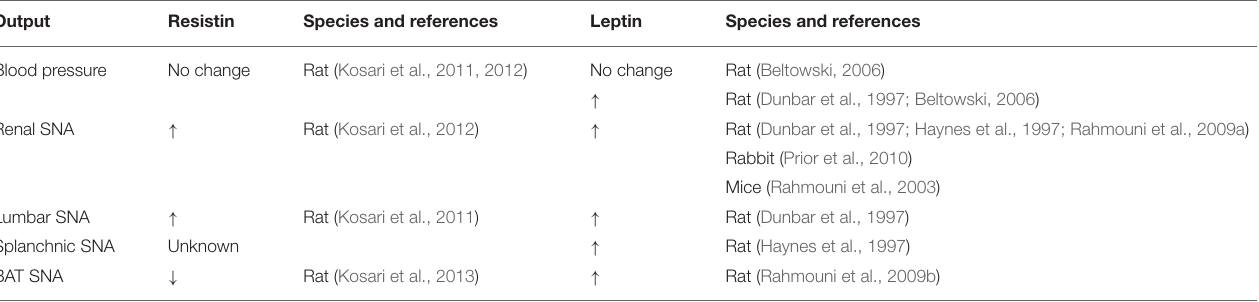
TABLE 1 | Comparison of effects of resistin and leptin on blood pressure and sympathetic nerve activity (SNA) to different cardiovascular and thermogenic outputs. Output